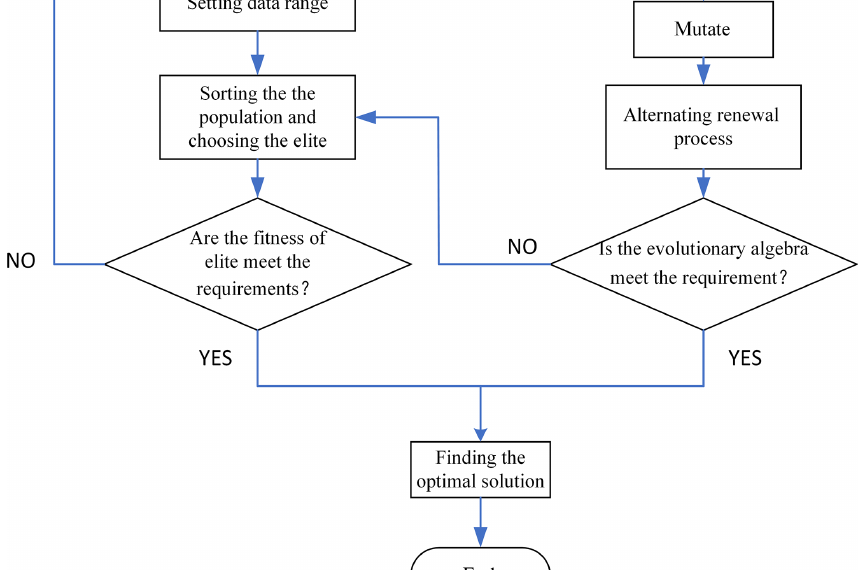
Figure 8. Flow chart of genetic algorithm.